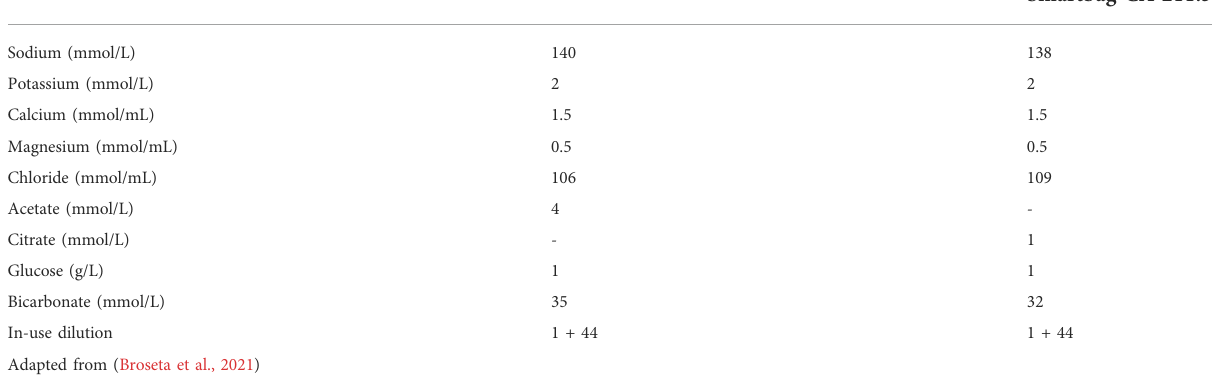
TABLE 1 Dialysate characteristics and